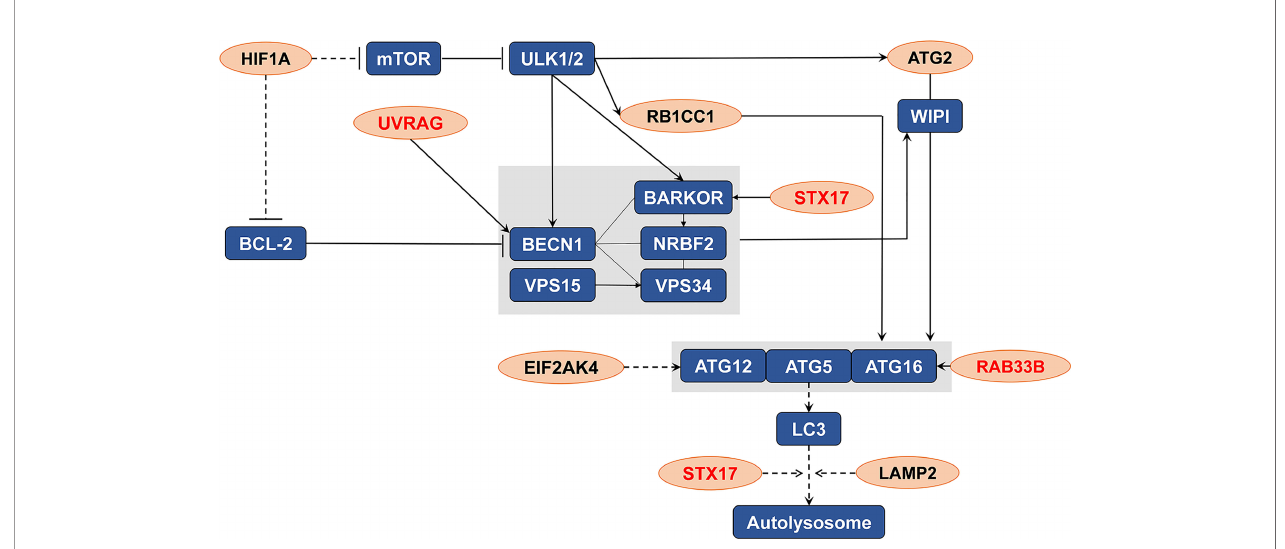
FIGURE 10 | The distribution of the eight genes in autophagy pathway (map04140). The eight genes (indicated as orange oval) were the potential targets of SLC7A11 as a ceRNA in 379 ovarian cancers which signi fi cantly and positive co-expressed with the SLC7A11, and the three genes (indicated in red) were those co- expressed in 90 drug resistant ovarian cancer